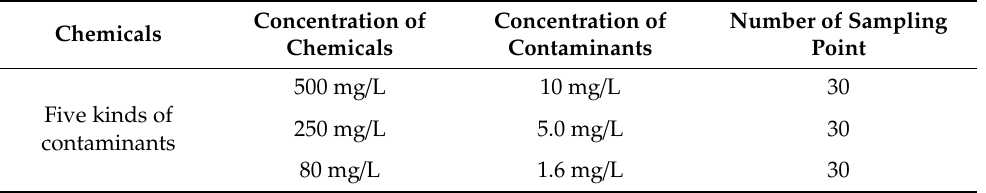
Table 2. Information on characteristic contaminants used for testing.